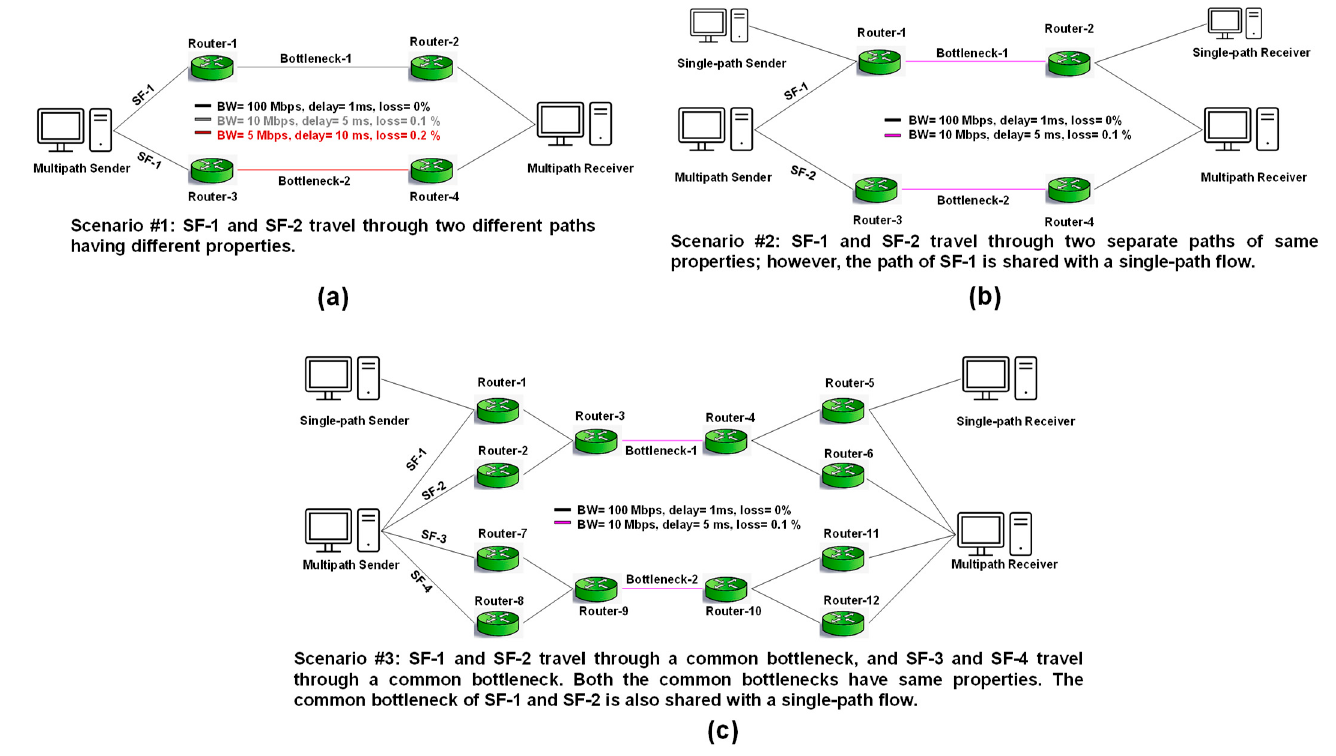
Figure 3. Illustration of the considered scenarios: ( a ) Scenario #1, ( b ) Scenario #2, and ( c ) Scenario #3.